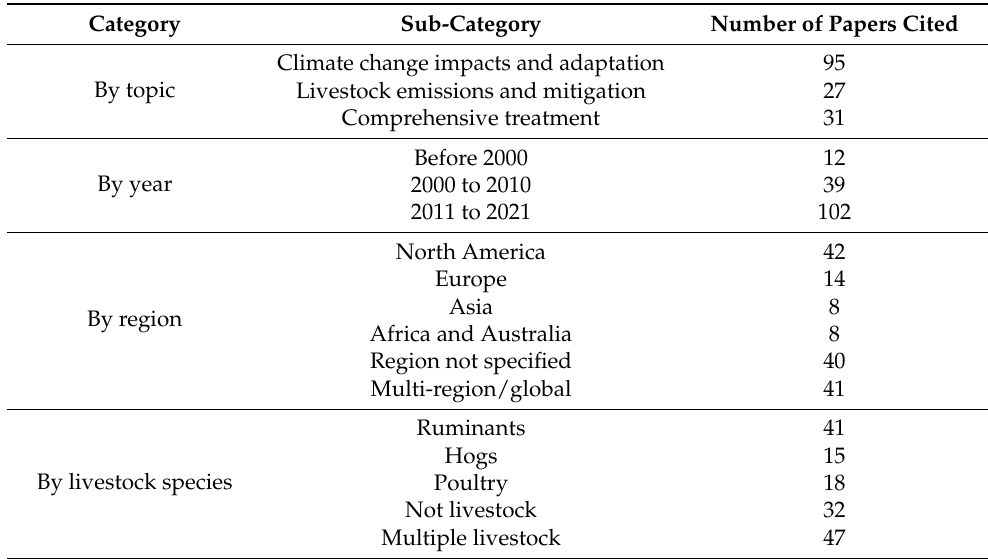
Table 1. Counts of papers used in the review by category.